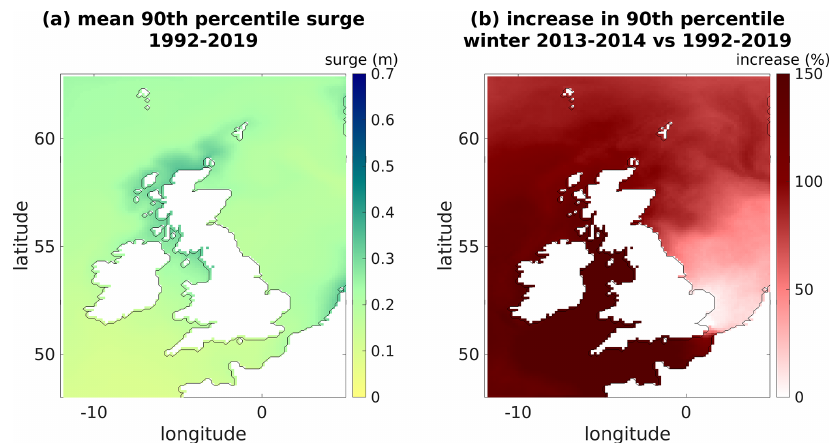
Figure 4. Mean of the surge 90th percentile from the climatology run (a) . Percentage increase in surge in winter 2013/4 compared to climatology data (1992–20019) from CS3 (1992–2006) and CS3X (2007–2019) simulations (b) . Note that the colour scales are different between Figs. 3–4.